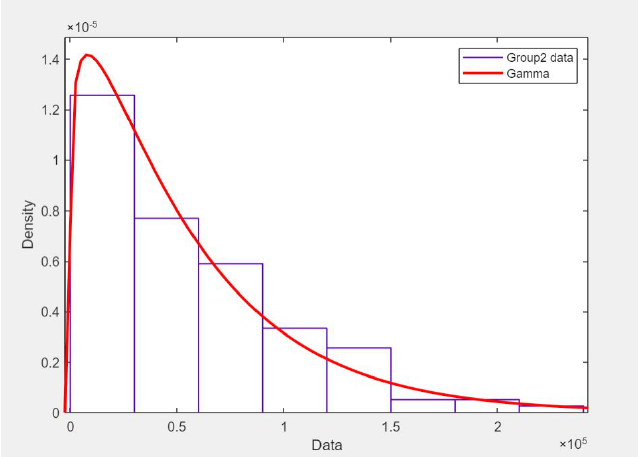
Figure 9. HISTFIT for group 2 in Category A